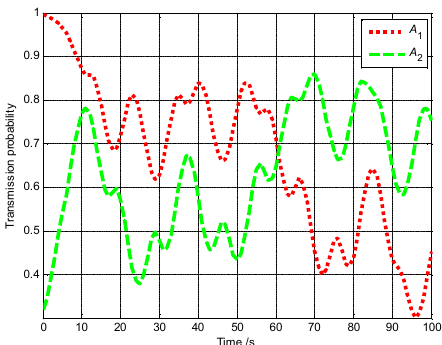
Figure 15. The probabilities of successful transmission of A 1 and A 2 to base station (Group B in Scenario 1).